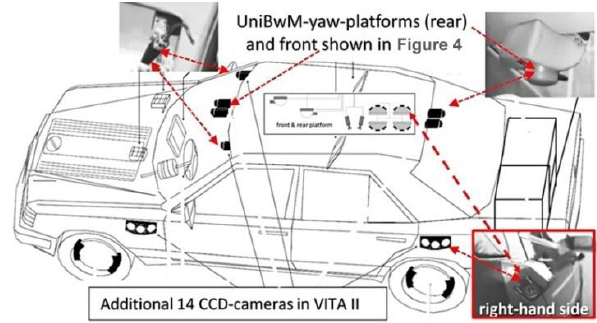
Figure 5. Camera arrangement in VITA_2 of Daimler 1994 to 1996. The rectangular insert in the